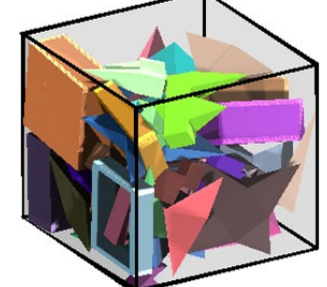
Fig. 22. Best solution obtained of the instance SGPS04 nc30